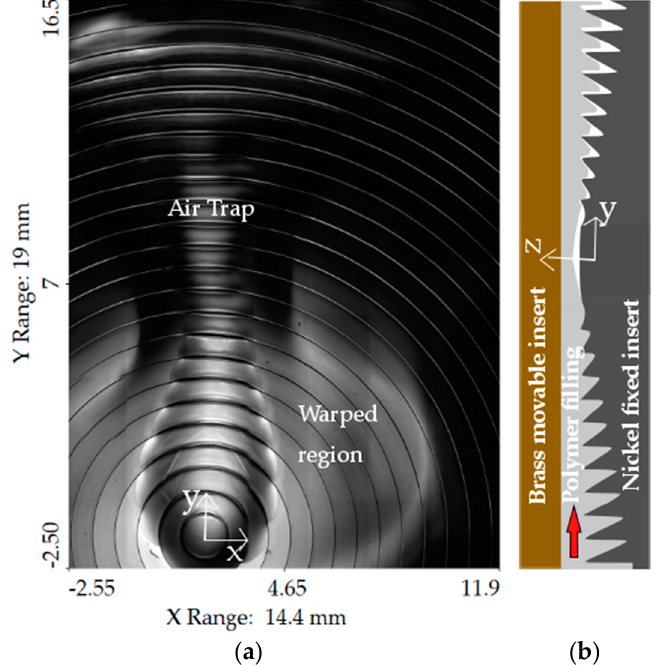
Figure 10. Combination of warpage and air trap in the replication of PMMA in ICM without holding: ( a ) Top view of the defect in the central location of the lens; ( b ) schematic visualization of air trap formation inside the mold cavity during the filling phase.